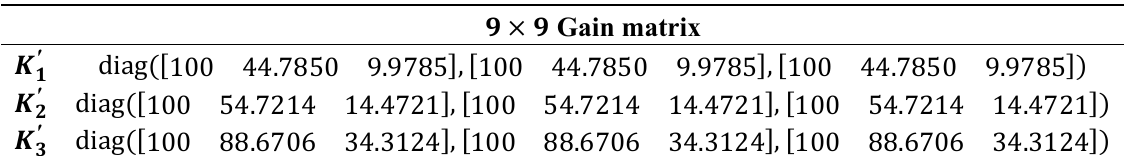
Table 4. LQR gain values.